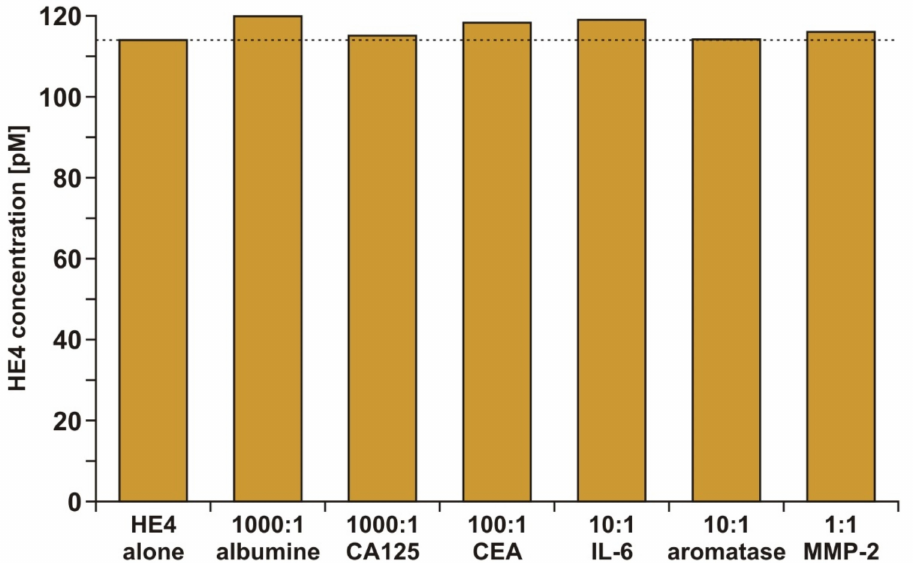
Figure 3. Specificity of HE4 determination. The determination of HE4 (114 pM) in the presence of variable excesses of potential